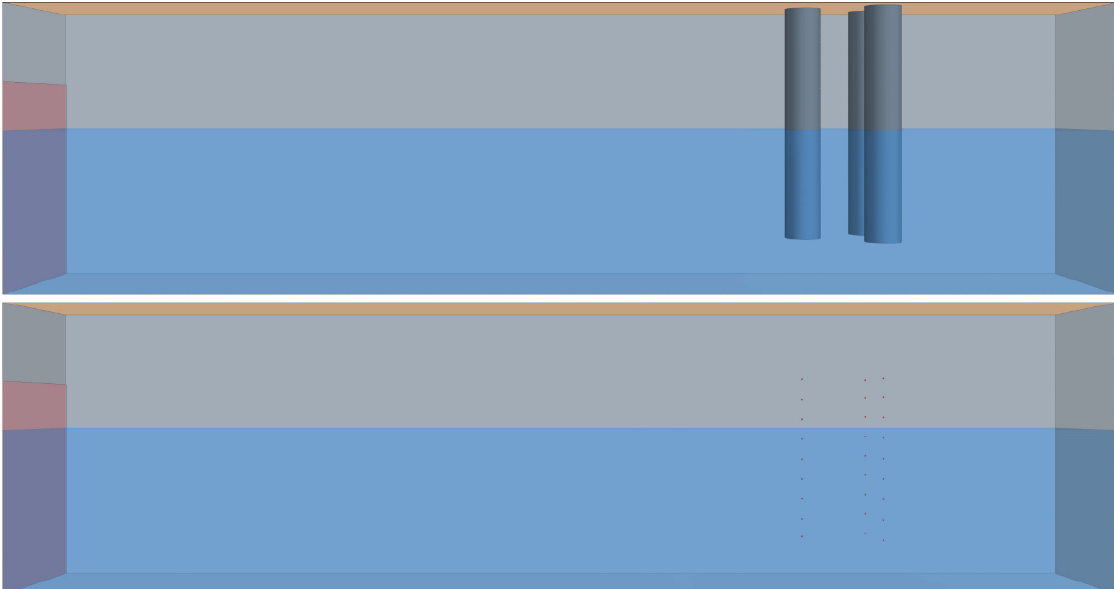
Figure 9. Arrangement of the three cylinders for the tripod configuration in the second scenario ( top )